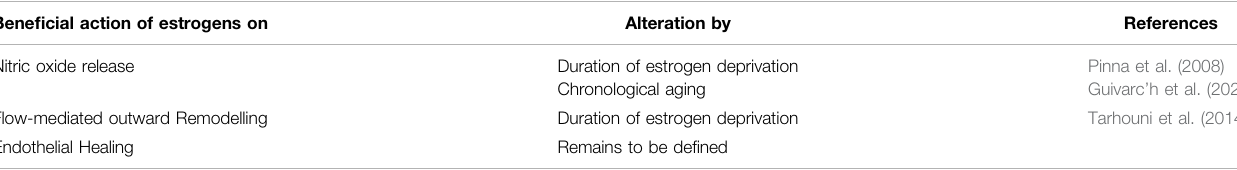
TABLE 3 | Impact of estrogen deprivation and aging on bene fi cial action of